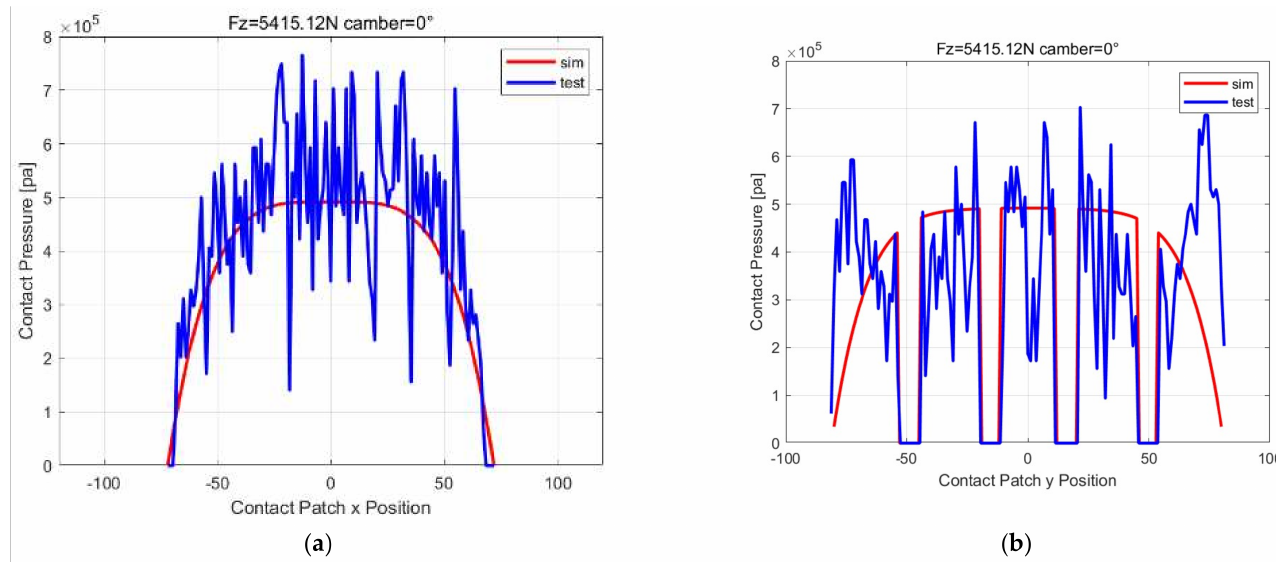
Figure 8. Contact pressure comparison between model and test. ( a ) Contact pressure along x center line; ( b ) Contact pressure along y center